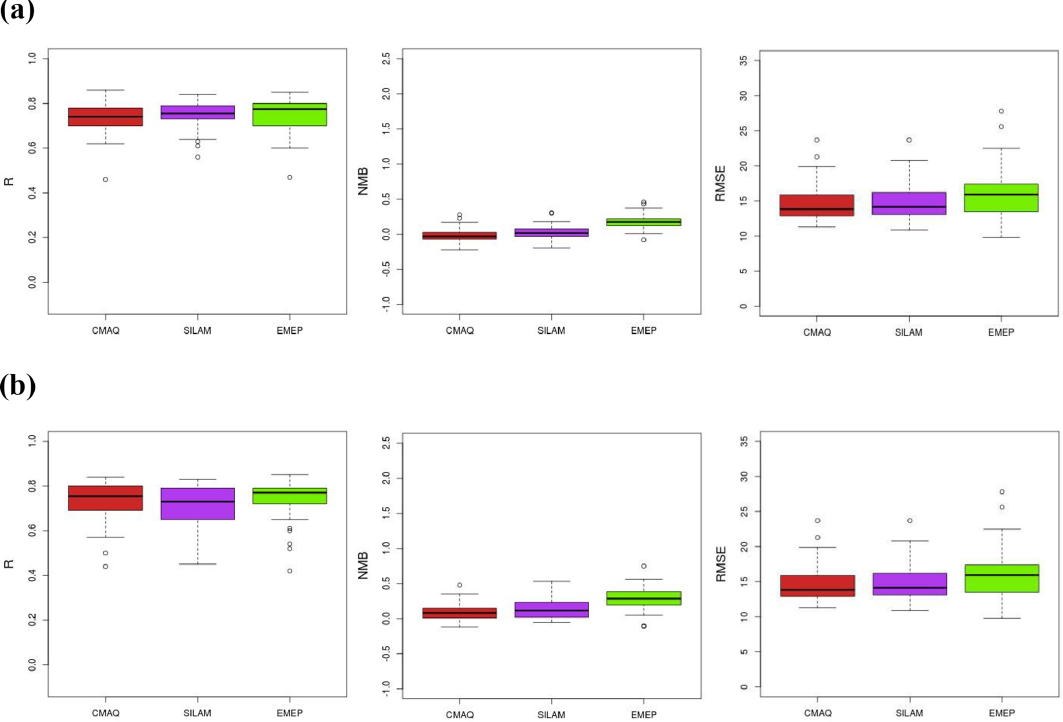
Figure 4. Comparison of statistical indicators for O 3 daily means (in the order R , NMB and RMSE) between three CTMs at (a) rural background stations and (b) urban background stations. Outliers shown as small